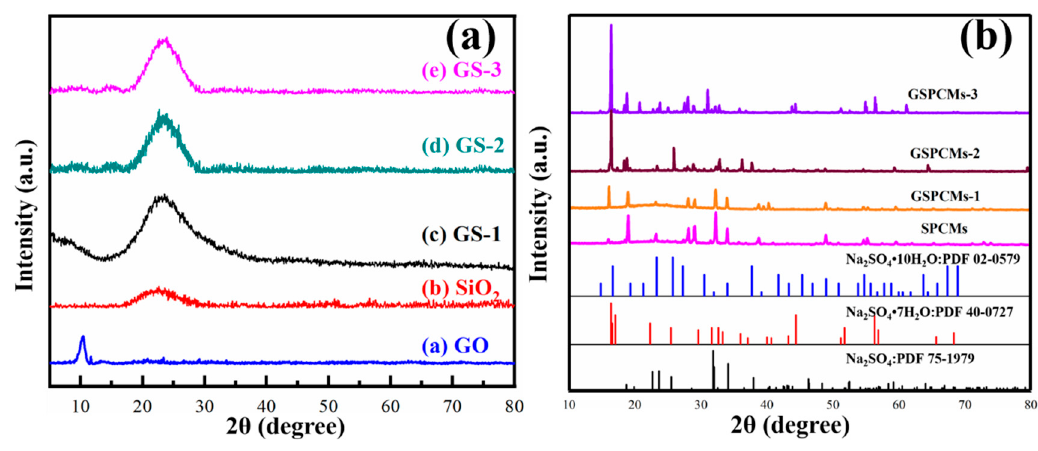
Figure 5. X-ray powder diffractometer (XRD) patterns of ( a ) GO, SiO 2, GS-1, GS-2 and GS-3; ( b ) Na 2 SO 4 ·10H 2 O, S-PCMs, GS-PCMs-1, GS-PCMs-2 and GS-PCMs-3.